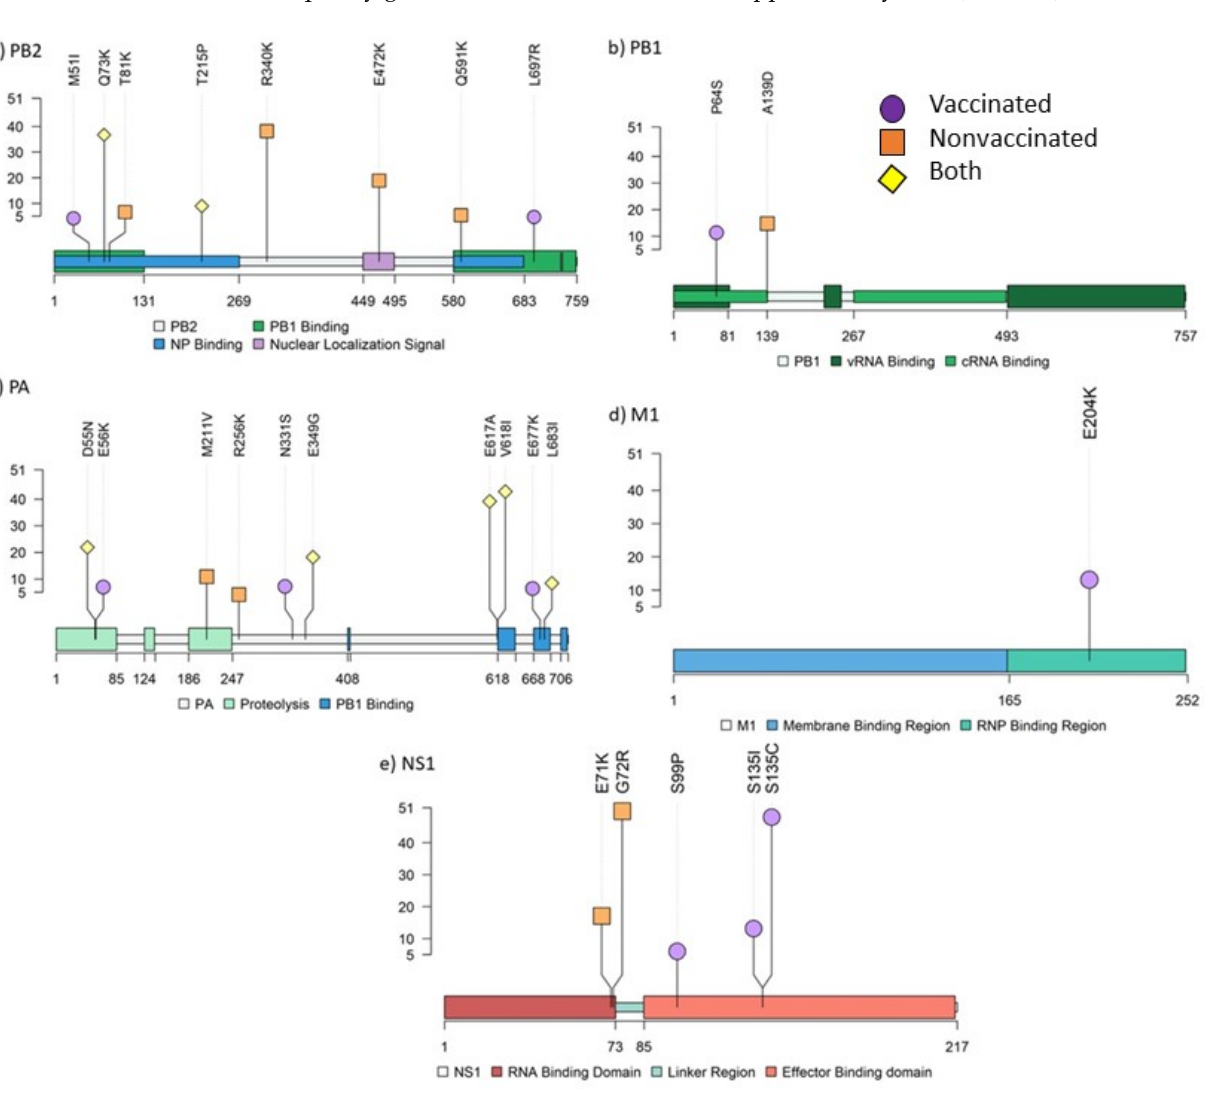
Figure 8. Lolliplot representing the allocation of all amino acid substitutions with an allele frequency greater than 5% found in PB2 ( a ), PB1 ( b ), PA ( c ), M1 ( d ), and NS1 ( e ) SIV proteins. Allele frequency of each variant is indicated on ordinate axis. If one substitution was found in more than one sample, only the highest allele frequency is indicated. Amino acid substitutions from vaccinated, nonvaccinated, and both groups are represented in purple circles, orange squares, and yellow diamonds,